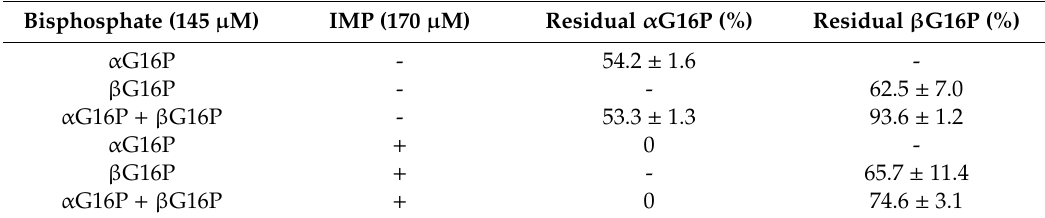
Table 1. Phosphatase activity monitored by 31 P-NMR. A total of 40 µ g PMM1 were incubated for 90 min at 32 ◦ C with 145 µ M α G16P or β G16P or a combination of both, in the absence ( − ) or the presence ( + ) of inosine monophosphate (IMP) 170 µ M. Bisphosphate (145 µ